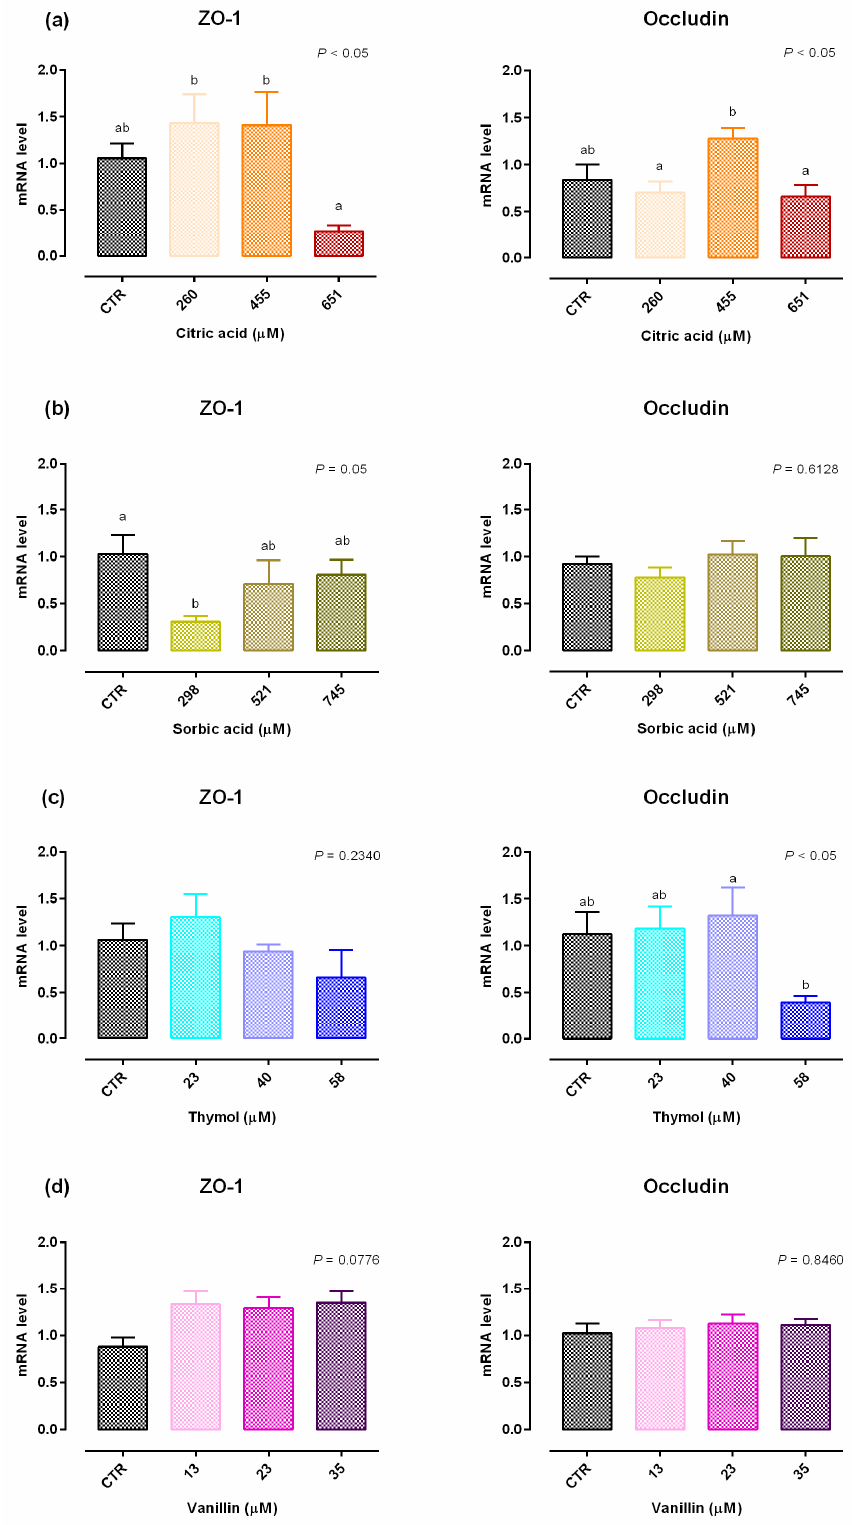
Figure 3. Gene expression in Caco-2 cells after 15 days of treatment with single OA and NIC. Values are least square means ( n = 6) ± SEM represented by vertical bars. A modification of the 2 – ∆∆ CT method [16] was used to analyze the relative expression (fold changes), calculated relative to the control group. Means with di ff erent letters indicate statistical significance with p < 0.05 (a, b); means with at least